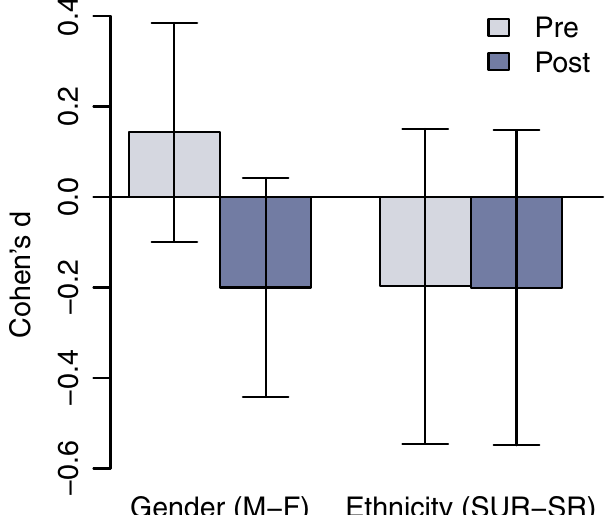
FIG. 3. Effect sizes of disaggregated groups. In all cases, differences between group means are at or below the threshold for small effect size, with error bars crossing the axis indicating no meaningful